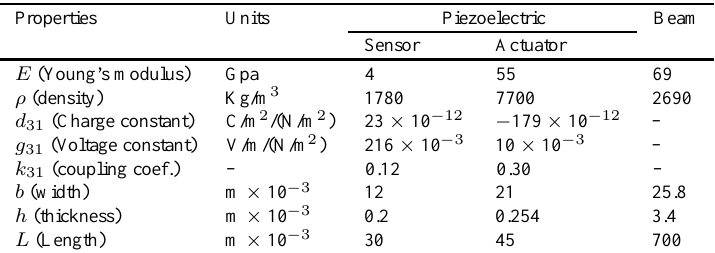
Fig. 8. Scheme of the experimental setup for system model identification. Table 1 Characteristics of the